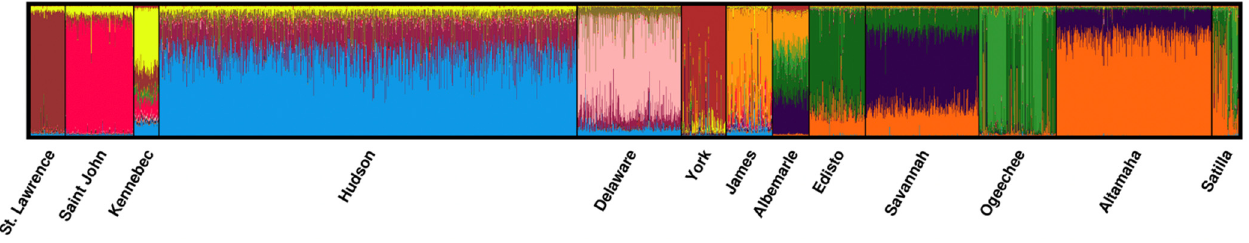
Figure 2. STRUCTURE analysis of the coastwide population structure of 3404 Atlantic sturgeon specimens based on the microsatellite analysis of 11 loci from 13 collection sites ranging from the St. Lawrence River, Quebec to the Satilla River, Georgia. Each vertical bar represents a single individual, and different colors represent the contribution of each K genetic cluster to each specimen’s genotype. This figure depicts the results of K = 13 genetic clusters.